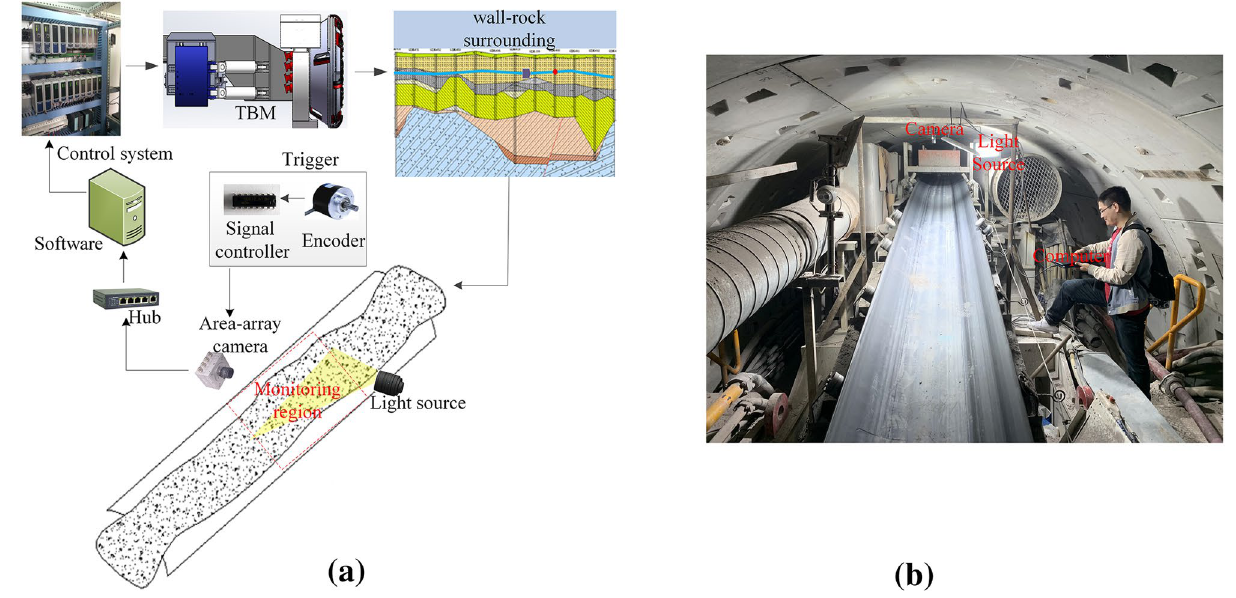
Figure 2. The visual assessment system. ( a ) Schematic diagram of the system. ( b ) Field test.